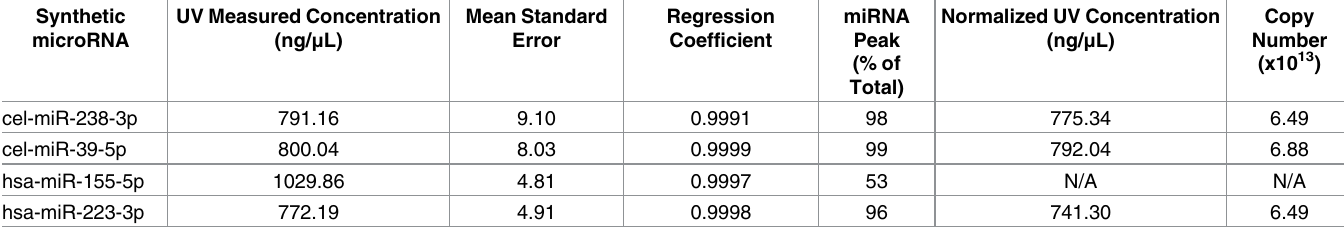
Table 2. Measured values of synthetic RNA oligonucleotides. Synthetic microRNA